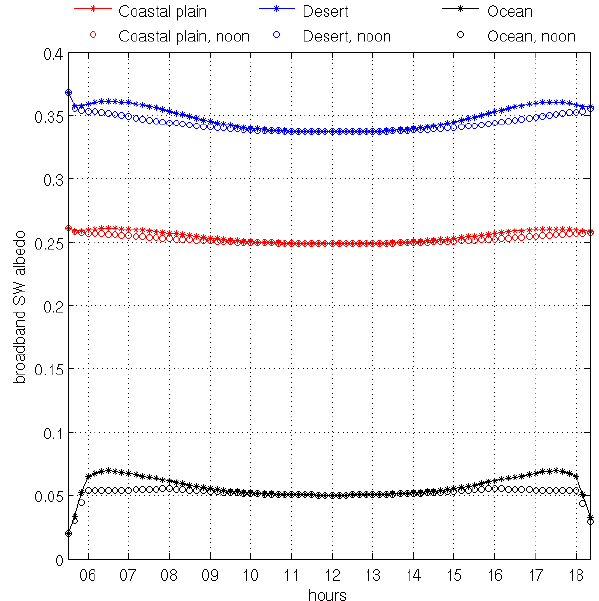
Figure 13. Special cases of the SW DRF diurnal cycle for the black surface (black), desert (red) and white surface (blue) surface albedos. (cid:49)F TOA , (cid:49)F A and (cid:49)F BOA (from top to bottom rows) are computed for the non-absorbing and absorbing (first two and last two columns respectively) and for the isotropic and anisotropic (first, third and second, fourth columns respectively) aerosol cases. Spectrally gray override values are provided in the titles, where g ∗ and ω ∗ indicate that actual spectral values were used. Total column AOD at 674nm is 0.5.